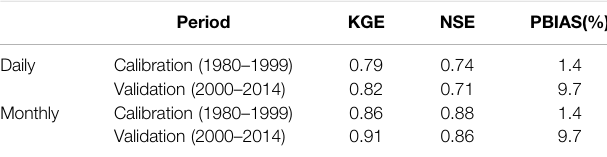
TABLE 4 | Evaluation of the XAJ model performance at daily and monthly time step.